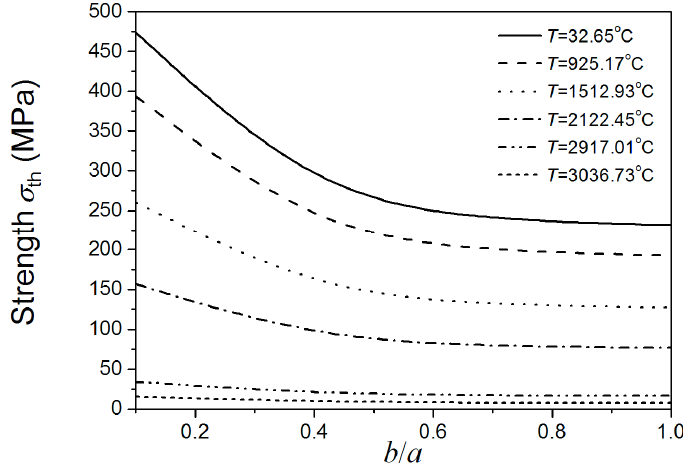
Figure 4. b / a ratio dependence of the material’s fracture strength under different temperatures ( a is a definite